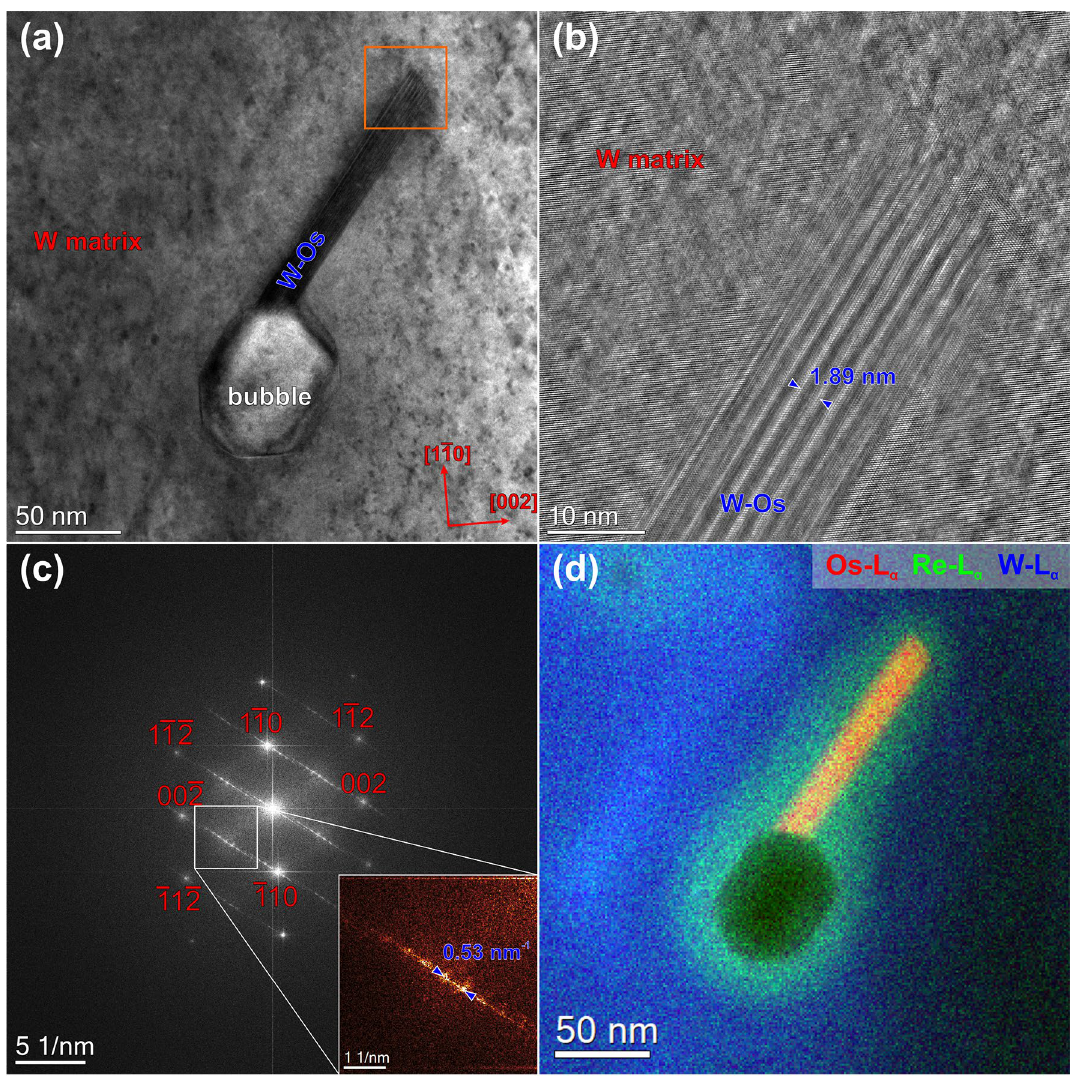
Figure 9. ( a ) TEM bright-field image of a faceted void attached to a W–Os rod. ( b ) High-resolution phase contrast image of the W–Os phase exhibiting Moiré fringes in the Os-rich part. ( c ) Diffractogram (FFT) of ( b ). ( d ) Composite STEM-EDX elemental map of the same sample